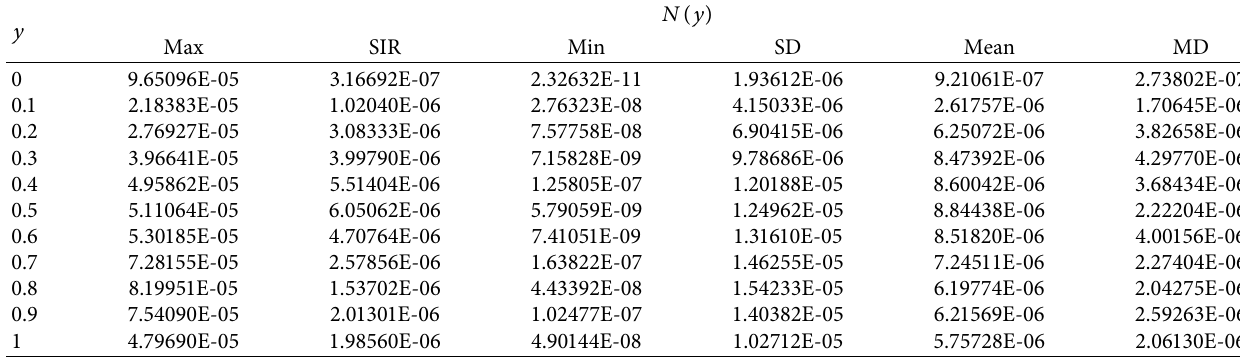
Table 6: Statistical performances for the class N ( y ) to solve the mathematical SEIR-NDC system.